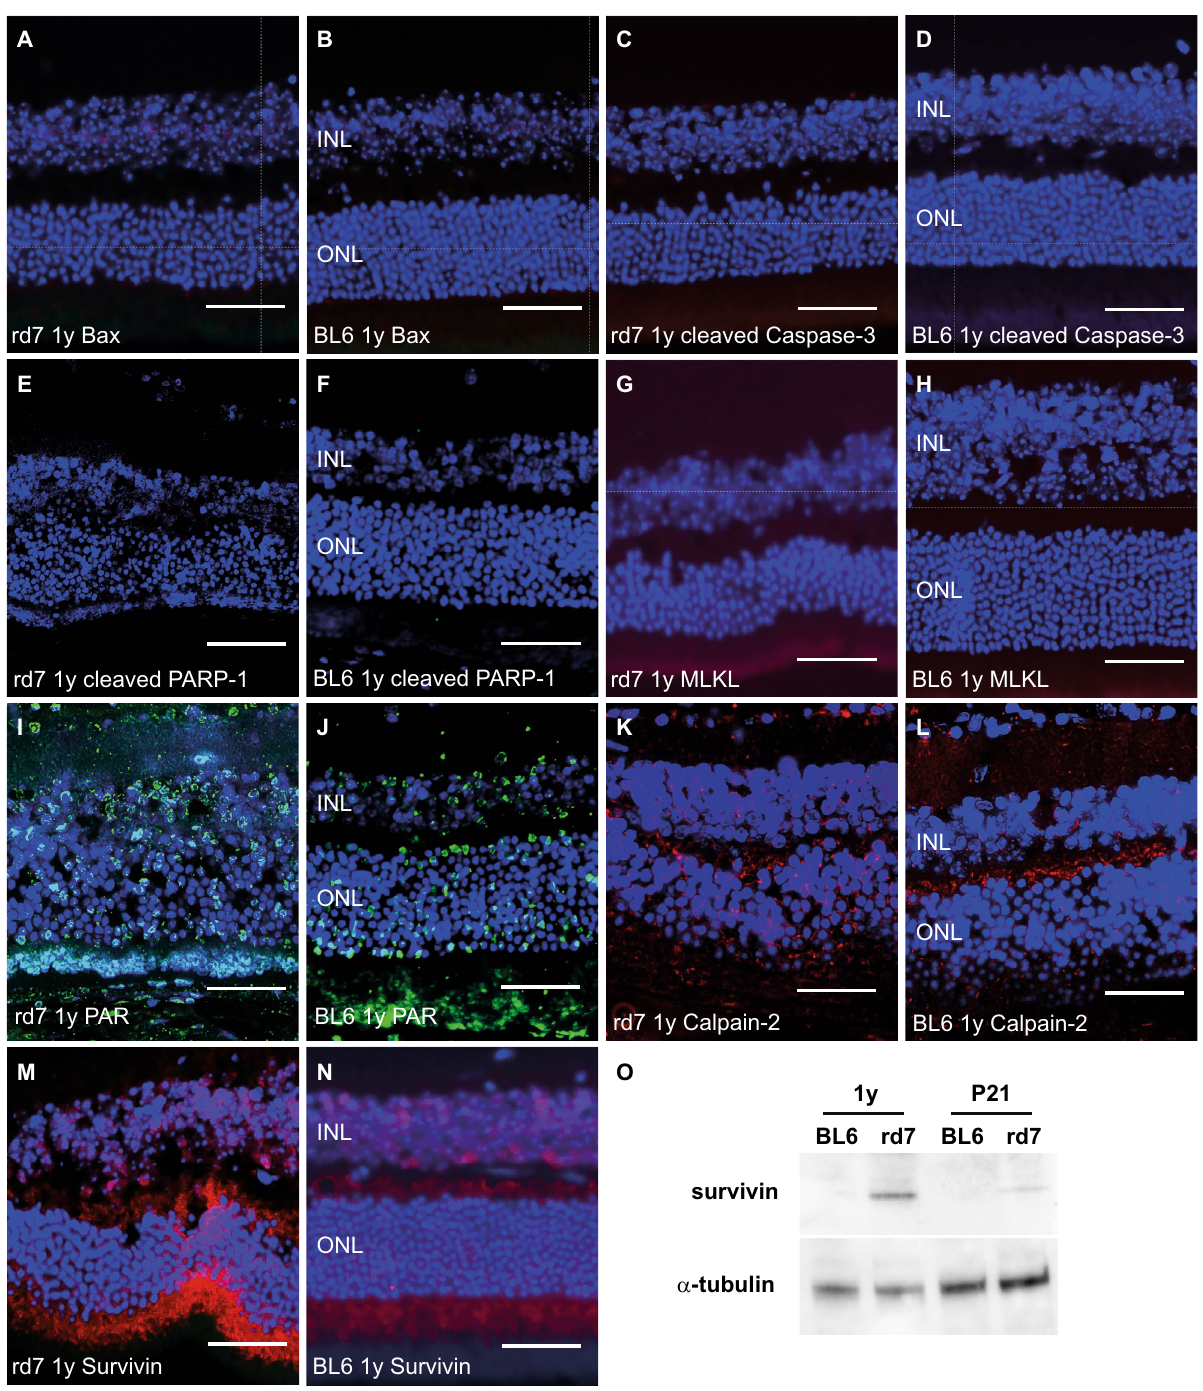
Figure 6. Cell death mechanisms in C57BL/6J Nr2e3 rd7/rd7 retinas. Immunohistochemical analysis of cell death markers on 5 μM-paraffin sections of 1-year-old (1y) C57BL/6J Nr2e3 rd7/rd7 (rd7) ( A , C , E , G , I , K , M ) and wild- type C57BL/6J (BL6) ( B , D , F , H , J , L , N ) retinas. Sections were probed with antibodies raised against Bax ( A , B ), cleaved Caspase-3 ( C , D ), cleaved PARP-1 ( E , F ), MLKL ( G , H ), PAR ( I , J ), Calpain-2 ( K , L ) and Survivin ( M , N ). Bax, cleaved Caspase-3, MLKL and Survivin were detected with a secondary antibody conjugated to Alexa Fluor 594 (red), cleaved PARP-1 and Calpain-2 with a secondary antibody conjugated to Cy5 (red) and PAR with a secondary antibody conjugated to FITC (green). Nuclei were stained with DAPI (blue), namely the outer nuclear layer (ONL) and the inner nuclear layer (INL). Scale bar: 50 µm. ( O ) Qualitative Western blot analysis on six pooled retinas of 21-day (P21) and 1-year-old (1y) C57BL/6J (BL6) and C57BL/6J Nr2e3 rd7/rd7 (rd7) mice. Expression of the 16-kDa survivin and 49-kDa α-tubulin proteins were